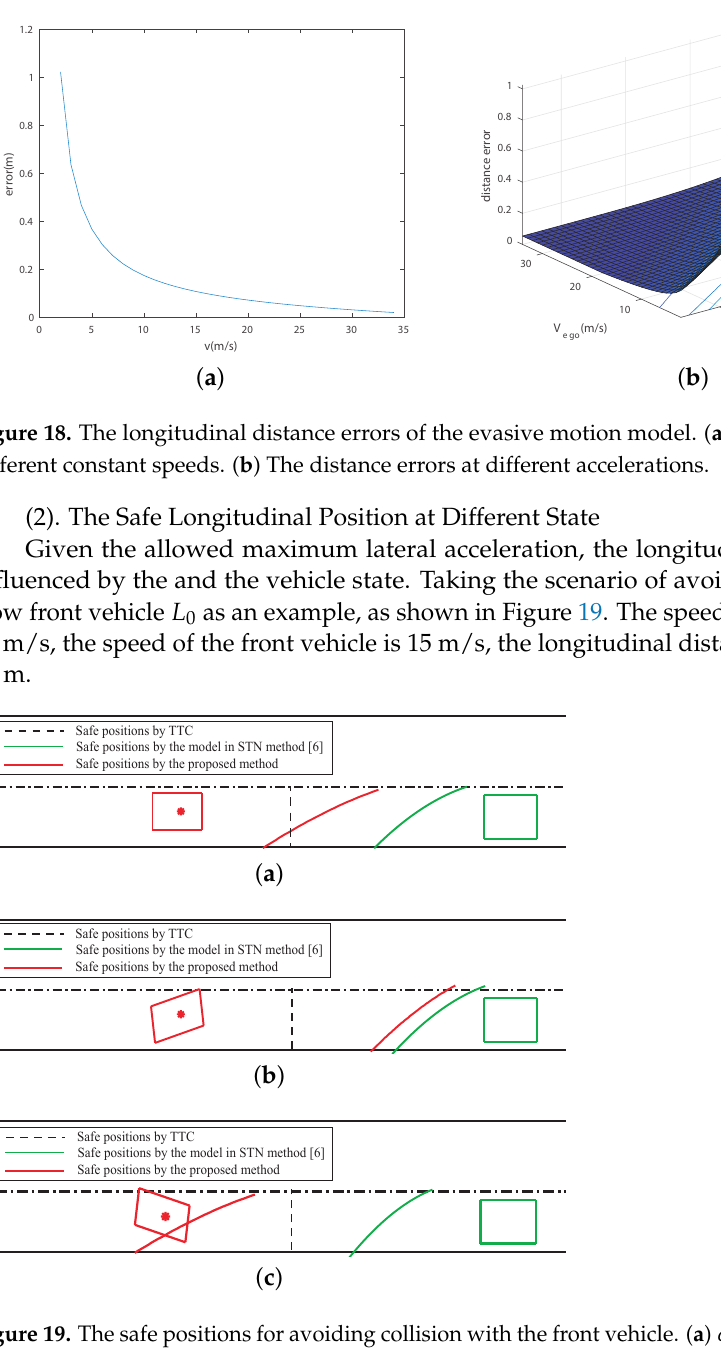
Figure 19. The safe positions for avoiding collision with the front vehicle. ( a ) ϕ ( t 0 ) = 0. ( b ) ϕ ( t 0 ) > 0. ( c ) ϕ ( t 0 ) <